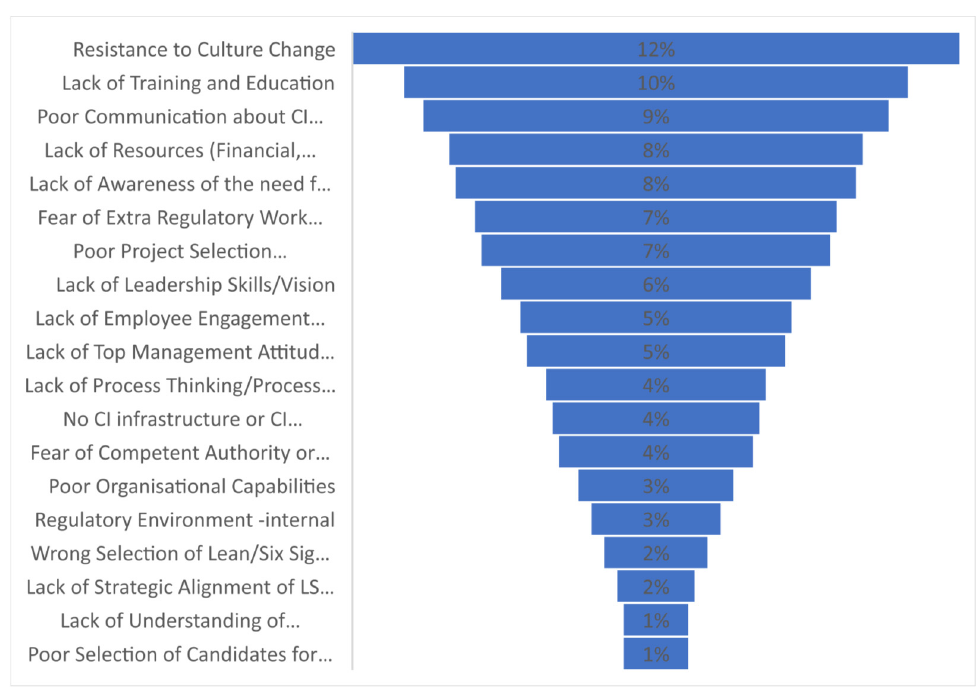
Figure 5. CFF’s of CI in the Irish pharma Industry.